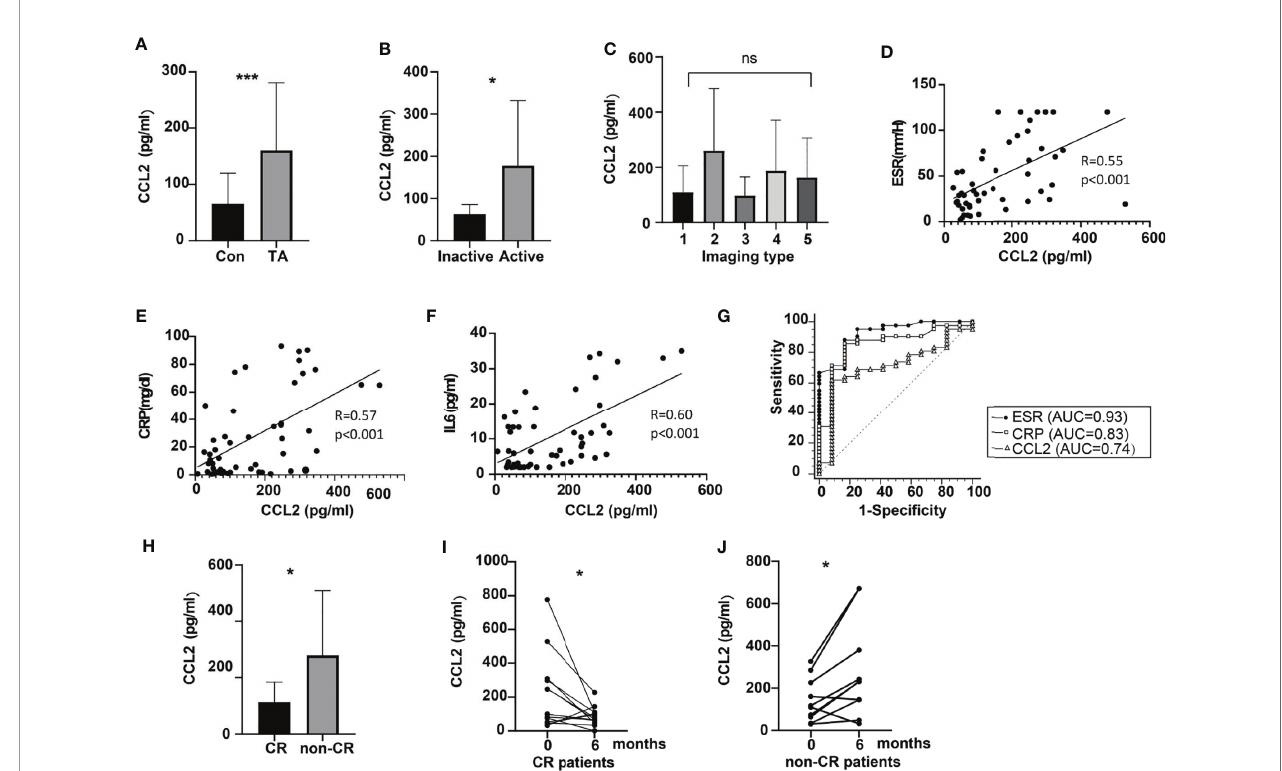
FIGURE 5 | Expression of peripheral CCL2 and the relationship of CCL2 levels with disease activity in patients with TA. (A) Levels of peripheral CCL2 in normal controls and patients with TA (n TA = 59, n control = 46, P < 0.001). (B) Levels of peripheral CCL2 in active and inactive patients with TA (n active = 46, n inactive = 13, P = 0.01). (C) Levels of peripheral CCL2 in patients with different imaging types (n type I = 20, n type II =8, n type III = 3, n type IV =2, n type v =26). (D – F) Relationship between CCL2 levels and ESR, CRP or IL-6 levels in patients with TA (n = 59) (G) . ROC of CCL2, ESR and CRP to predict disease activity in patients with TA (n = 59). (H) CCL2 levels in CR and non-CR patients (n CR = 24, n non-CR = 14, P = 0.02). (I) Changes of peripheral CCL2 levels in CR patients at baseline and the 6 th month after treatment (n = 24, P = 0.04). (J) Changes of peripheral CCL2 levels in non-CR patients at baseline and the 6 th month after treatment (n = 14, P = 0.02) AUC, area under the curve; CR, clinical remission; ESR, erythrocyte sedimentation rate; CRP, C-reactive protein, IL-6, interleukin 6; CCL2, chemokine (C-C motif) ligand 2; ROC, receiver operatic characteristic; TA, Takayasu arteritis; *< 0.05; ***< 0.001; ns, no signi fi